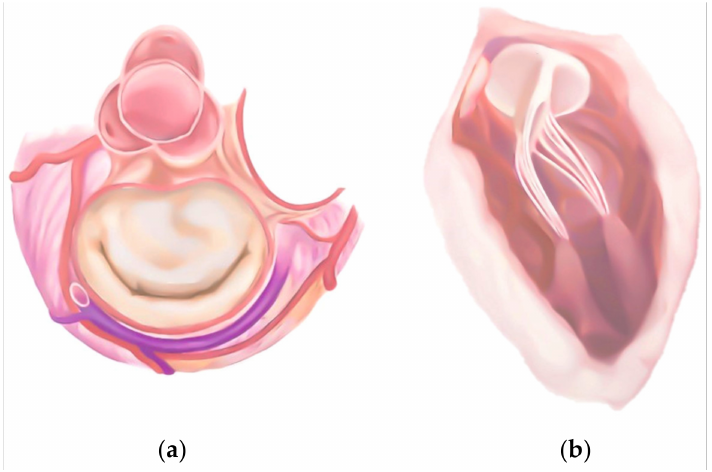
Figure 9. ( a ) Transverse and ( b ) sagittal planes of the mitral